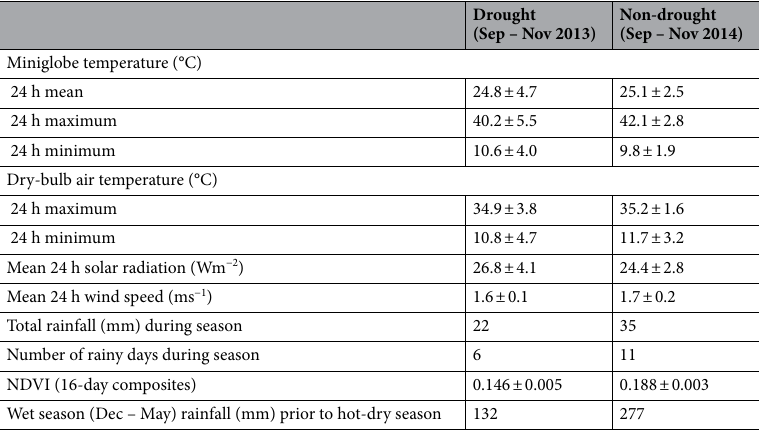
and outside of the 95% confidence interval of the long-term average (255 ± 56 mm between 1981 and 2017) for the study area 14 , whereas rainfall during the subsequent wet season (277 mm) was within the long-term range (Table 1). The lower rainfall preceding the drought period resulted in lower vegetation greenness (as indexed by NDVI) compared to the non-drought hot-dry season (Table 1; Fig. 1c). For consecutive 24 h periods, we calculated minimum, maximum and amplitude (maximum minus mini- mum) of the 24 h rhythm of body temperature. To determine behavioural adjustments in heat load brought about by microclimate usage, we calculated the difference between miniglobe temperature on the collar and the reference miniglobe per hour per individual animal. We calculated the time spent in microclimates cooler than direct sun by summing the hours when collar miniglobe was more than 0.5 °C lower than the reference miniglobe during daylight hours. We calculated a cumulative measure of cool microclimate usage during daylight hours per day as the sum of the hourly differences between collar miniglobe and reference miniglobe temperatures when animals were in cool microclimates (i.e., collar miniglobe was more than 0.5 °C lower than the reference miniglobe). To assess time spent travelling, we calculated the number of hours per day in which animals tra- versed more than 1.6 km within an hour, a distance previously associated with at least 50% of the hour engaged in directed movements at maximum walking speeds of ~ 3 km h −116,17 . We also calculated total 24 h activity and the proportion of activity that took place during the heat of the day (between 10:00 and 16:00) per individual. We used a series of Generalised Linear Mixed Models (GLMMs; Gaussian error family for continuous data, Binomial error family for proportions and Poisson error family for counts) to test the association between season and spe- cies in terms of body temperature profiles, cumulative measure of cool microclimate use and time spent in cool microclimates per day, time spent travelling per day, total 24 h activity and the proportion of activity that took place during the heat of the day (10:00 to 16:00). Model assumptions of residual normality and homoscedasticity were assessed graphically within R software 18 , informing subsequent data transformations and model choices. Season, species and an interaction between season and species were represented as fixed effects with individual animals and date included as random effects to control for repeated measures per individual per season. The response values of the body temperature profiles were heteroscedastic, so we included a variance structure and correlation structure within the models to correct for heteroscedasticity 19 . The total 24 h activity response values were log transformed for normality. We first fitted the global model, containing all the explanatory variables and interactions, then fitted season or species on their own. For example, our activity models took the form: log (total 24 h activity) ~ season + species + interaction between season and species + individual animals (random effect) + date (random effect). The coefficients reported are for the non-drought hot-dry season, wildebeest, and the interaction for wildebeest in the non-drought hot-dry season compared to the reference levels: drought, gemsbok, and gemsbok in the drought, respectively. Using model selection procedures of Akaike’s Information Criterion, corrected for small sample bias (AICc) and model weighting ( wi ) 20 , we established the importance of each fixed variable and identified which model best supported the data 21 . Of all the candidate models, all models with a difference in AICc value of < 2 were considered plausible and were used for making inferences 20 .